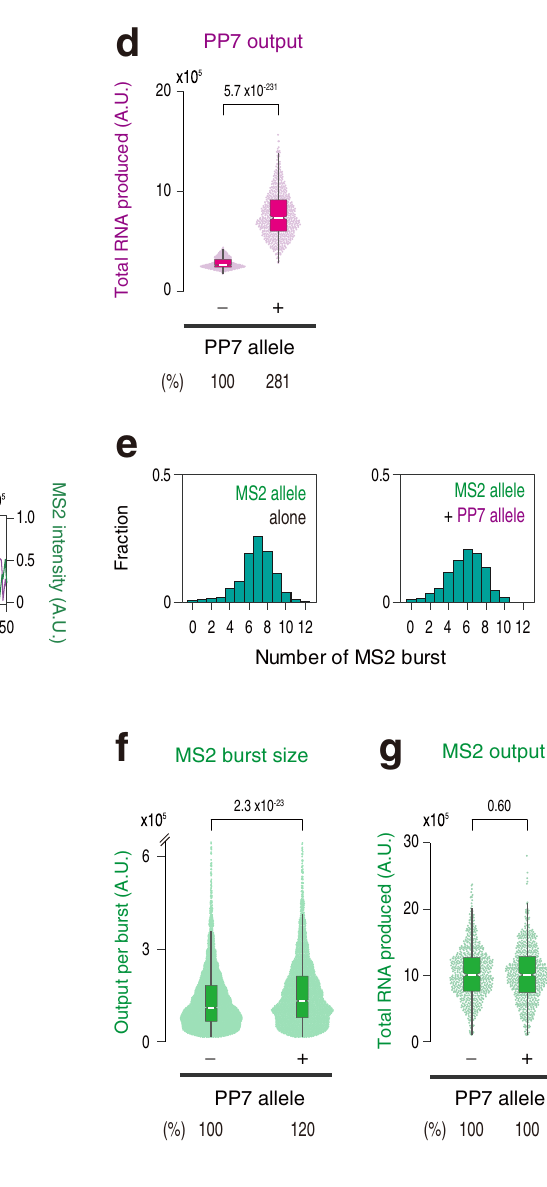
Fig. 2 | Non-coding transcripts do not affect target gene expression in trans. a The MS2-yellow reporter gene was placed under the control of a non-transcribed sna shadow enhancer (MS2 allele). Production of enhancer-derived non-coding transcripts was driven from the sna shadow enhancer located on the other homologous chromosome (PP7 allele). b Representative trajectories of transcrip- tionactivitiesoftheMS2allelewith(right)orwithout(left)thePP7allele. c MS2and PP7 trajectories for all the analyzed nuclei. Each row represents the MS2 or PP7 trajectory for a single nucleus. A total of 719 and 704 ventral-most nuclei, respec- tively, were analyzed from three independent embryos lacking (top) or containing (bottom) the PP7 allele. Nuclei were ordered by the onset of MS2 or PP7 tran- scription in nc14, separately. The same number of nuclei were analyzed hereafter. d BoxplotshowingthedistributionofthetotaloutputofPP7transcription.Thebox indicates the lower (25%) and upper (75%) quantile and the white line indicates the